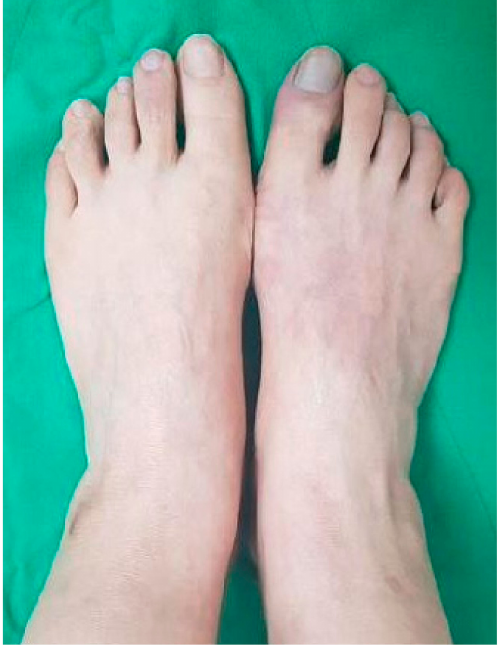
Figure 1. Purple discoloration of the right first toe.